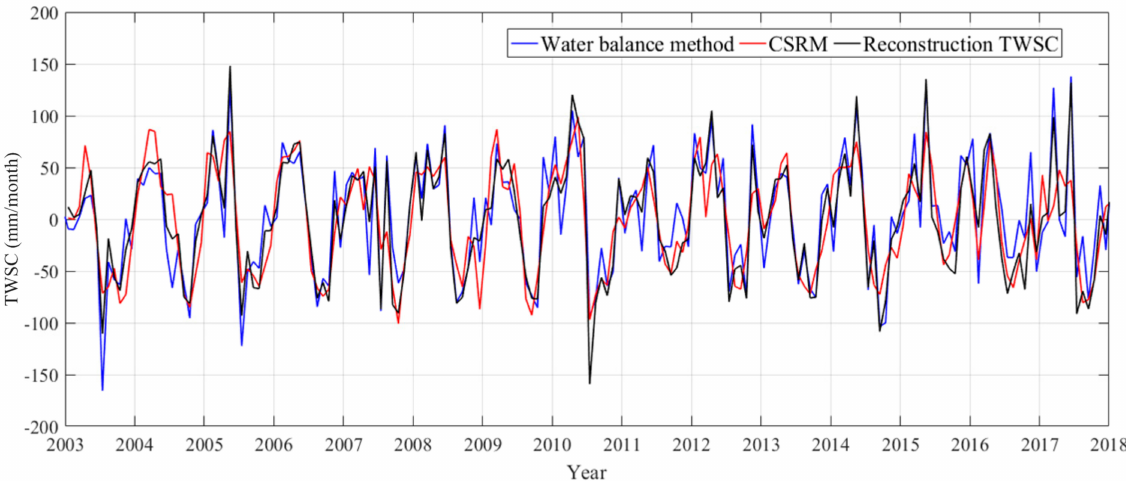
Figure 10. Comparison of TWSC calculated by different methods and CSRM in the Ganjiang River